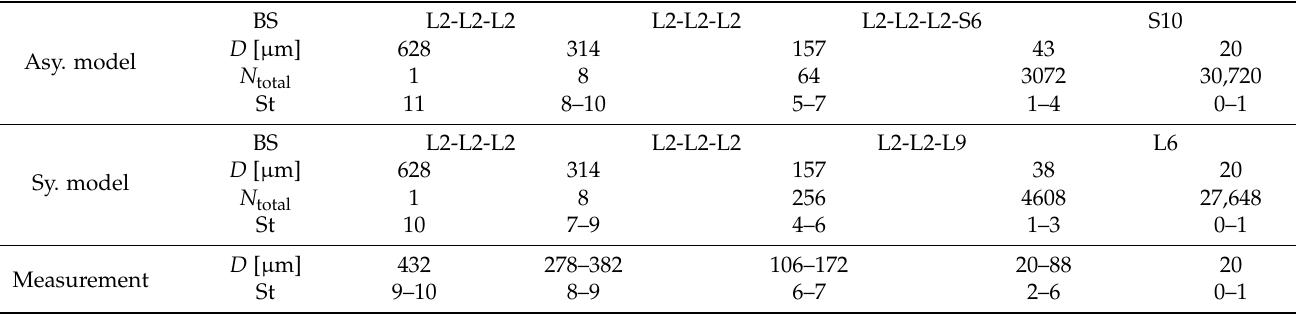
Table A1. Morphological parameters of the arterial structure in the asymmetrical (Asy.) and sym- metrical (Sy.) models. BS stands for the branching style of the vessels, ranging from renal artery to AAs, where “L” and “S” show the symmetrical and asymmetrical branching styles. D , N total and St are vessel diameter, vessel number and Strahler order, respectively. “Measurement” indicates the experimental data from Nordsletten et al. [23] in Table 2 and Table